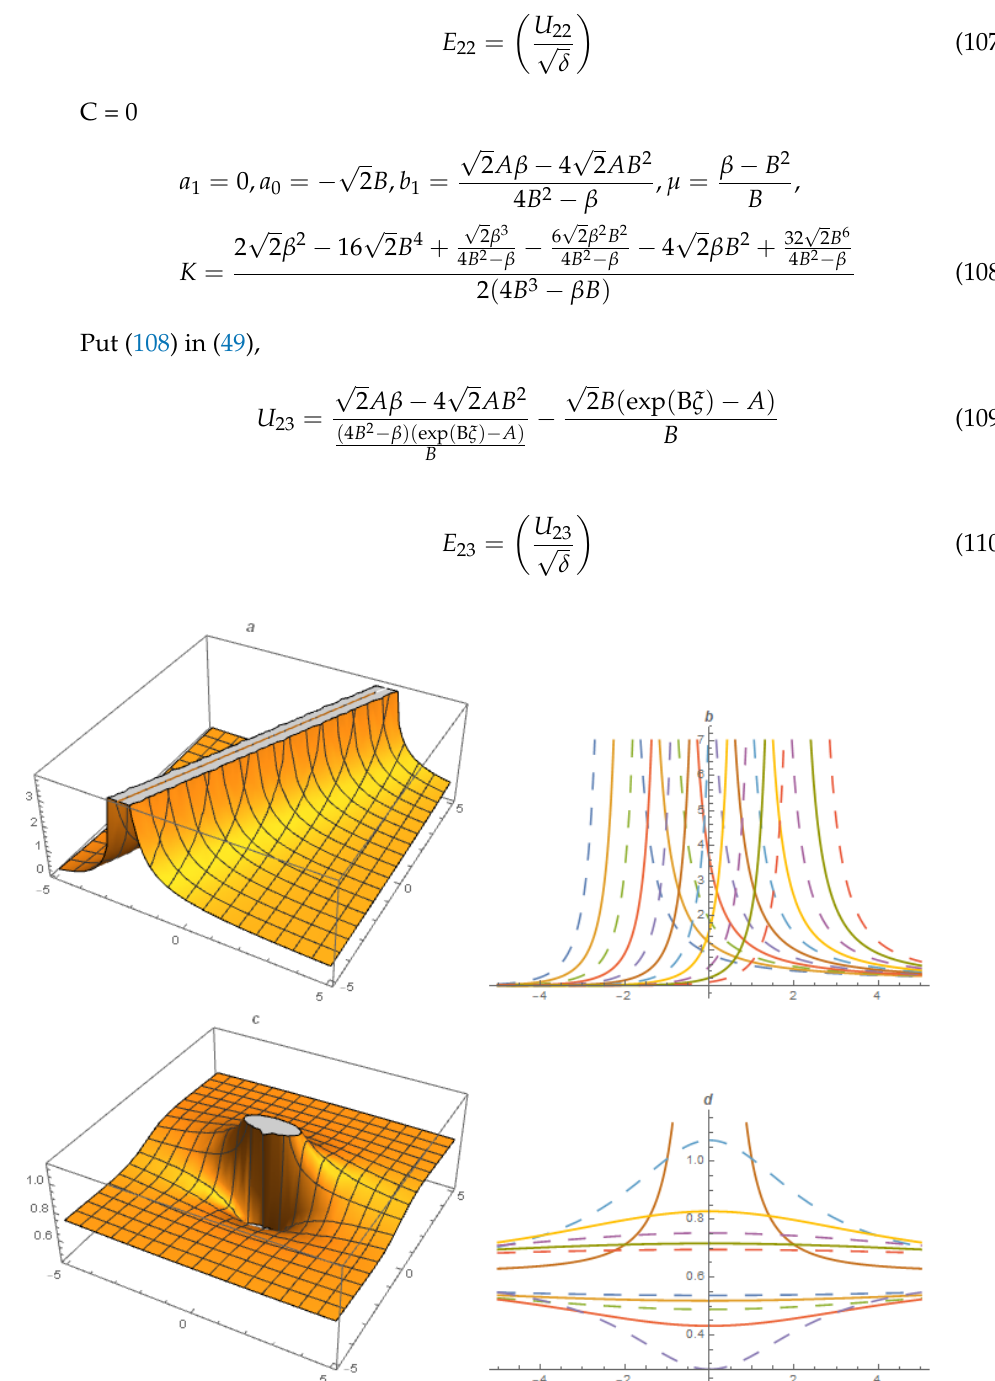
Figure 5. Solutions of U 22 ( a , b ) and E 22 ( c , d ) with α = 1, β = 0.1 and α = 1, β = − 3.1, δ = − 5.05,